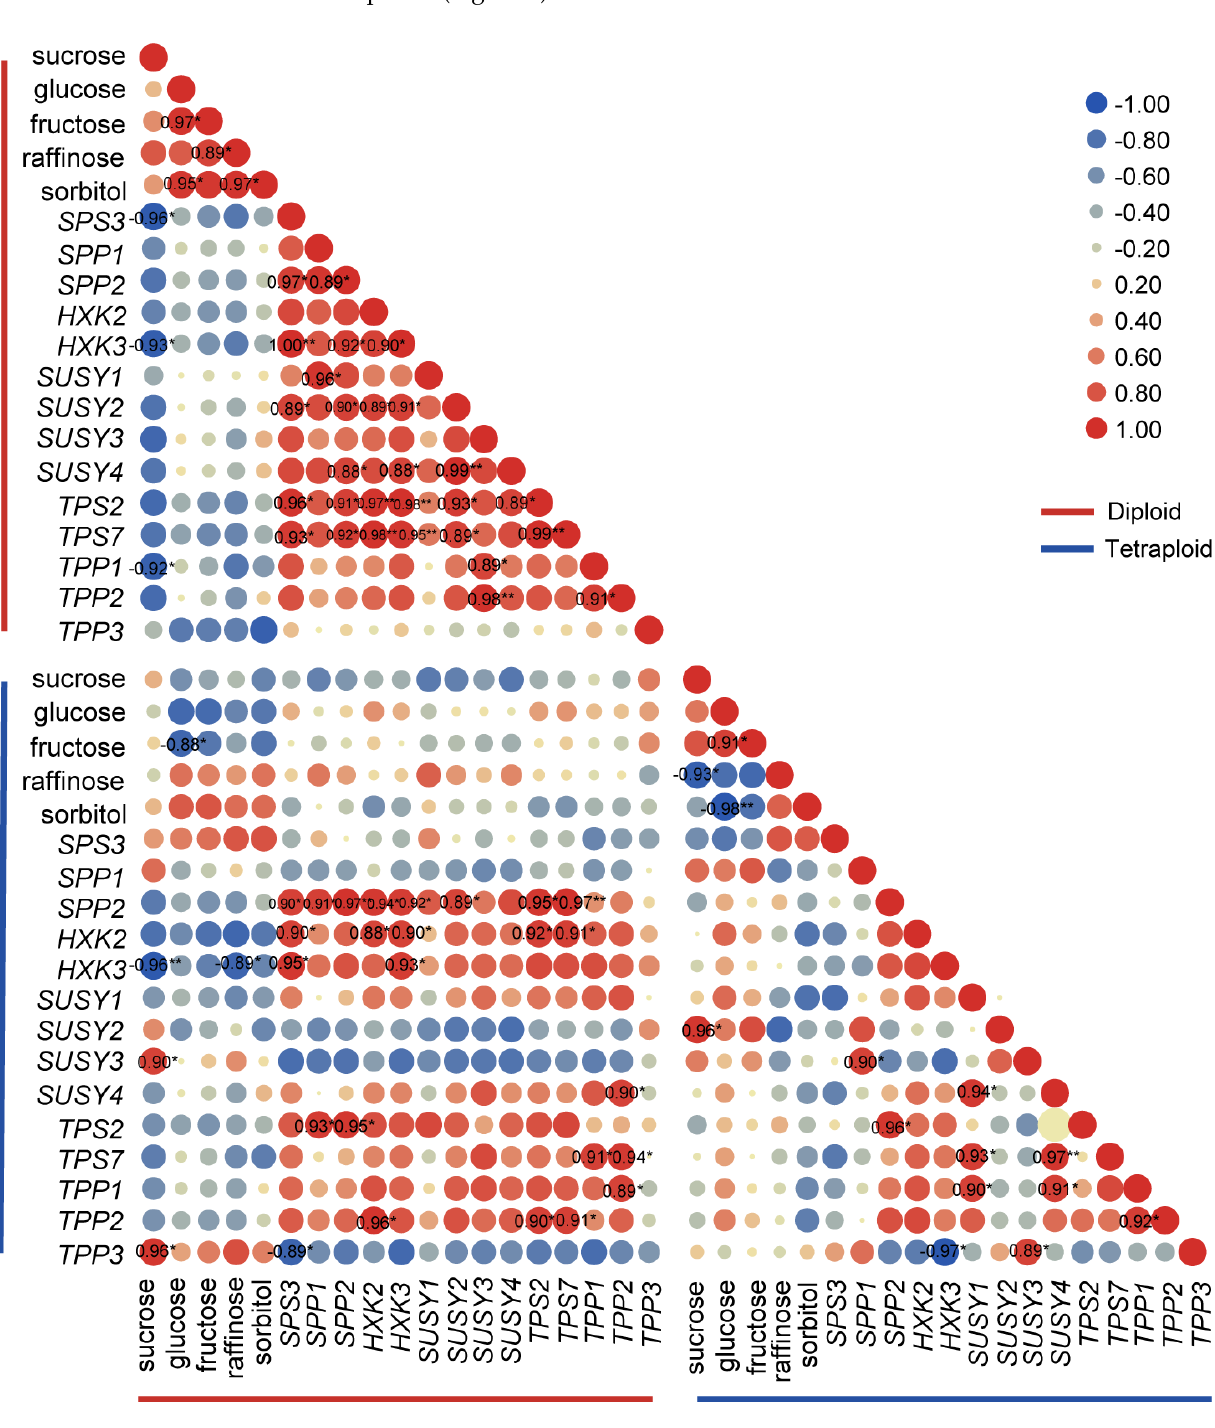
Figure 8. Correlation between two variables, nonstructural carbohydrate (NSC) contents and the expression level of sugar − related genes, in allodiploids and allotetraploids during development. Colors of blue to red represent levels of correlation. The numbers in circles are Pearson correlation values that are significantly different at p < 0.05 (*) or p < 0.01 (**).